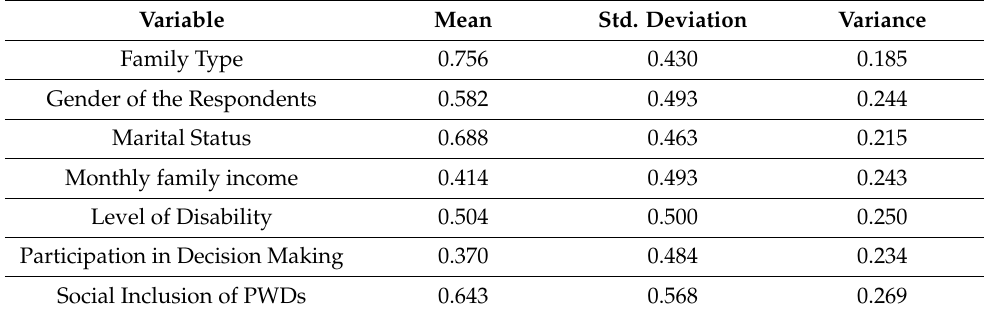
Table 6. Descriptive statistics.